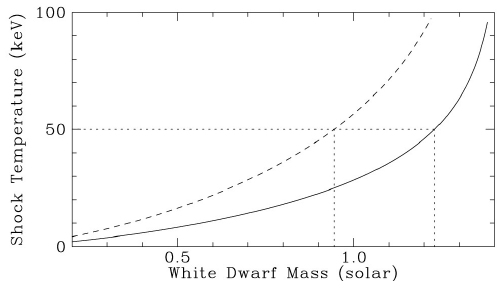
Figure 1: Possible white dwarf mass of V2487 Oph for the magnetic (dashed line) and the non-magnetic (solid line)